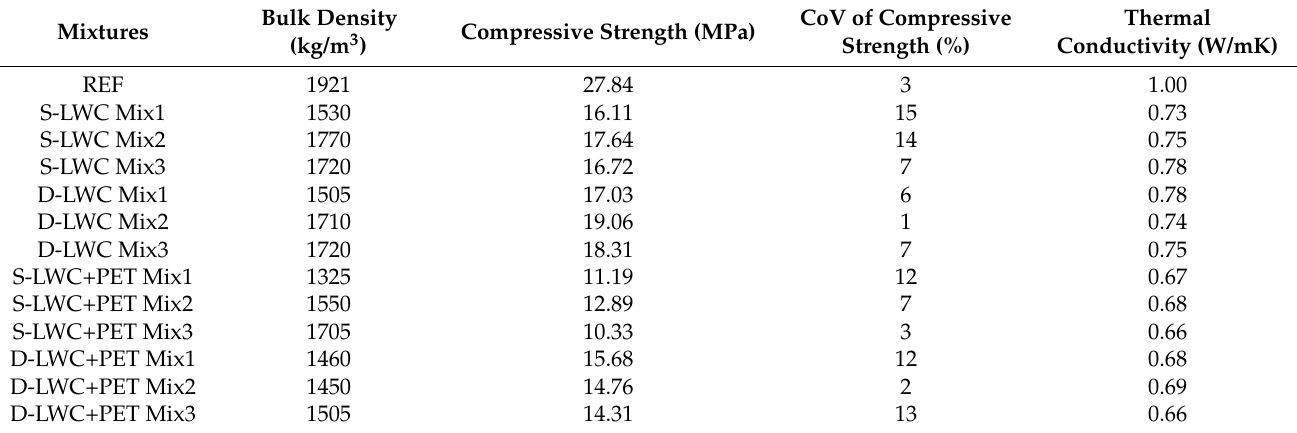
Table 7. Average density, compressive strength, and thermal conductivity of the tested concrete